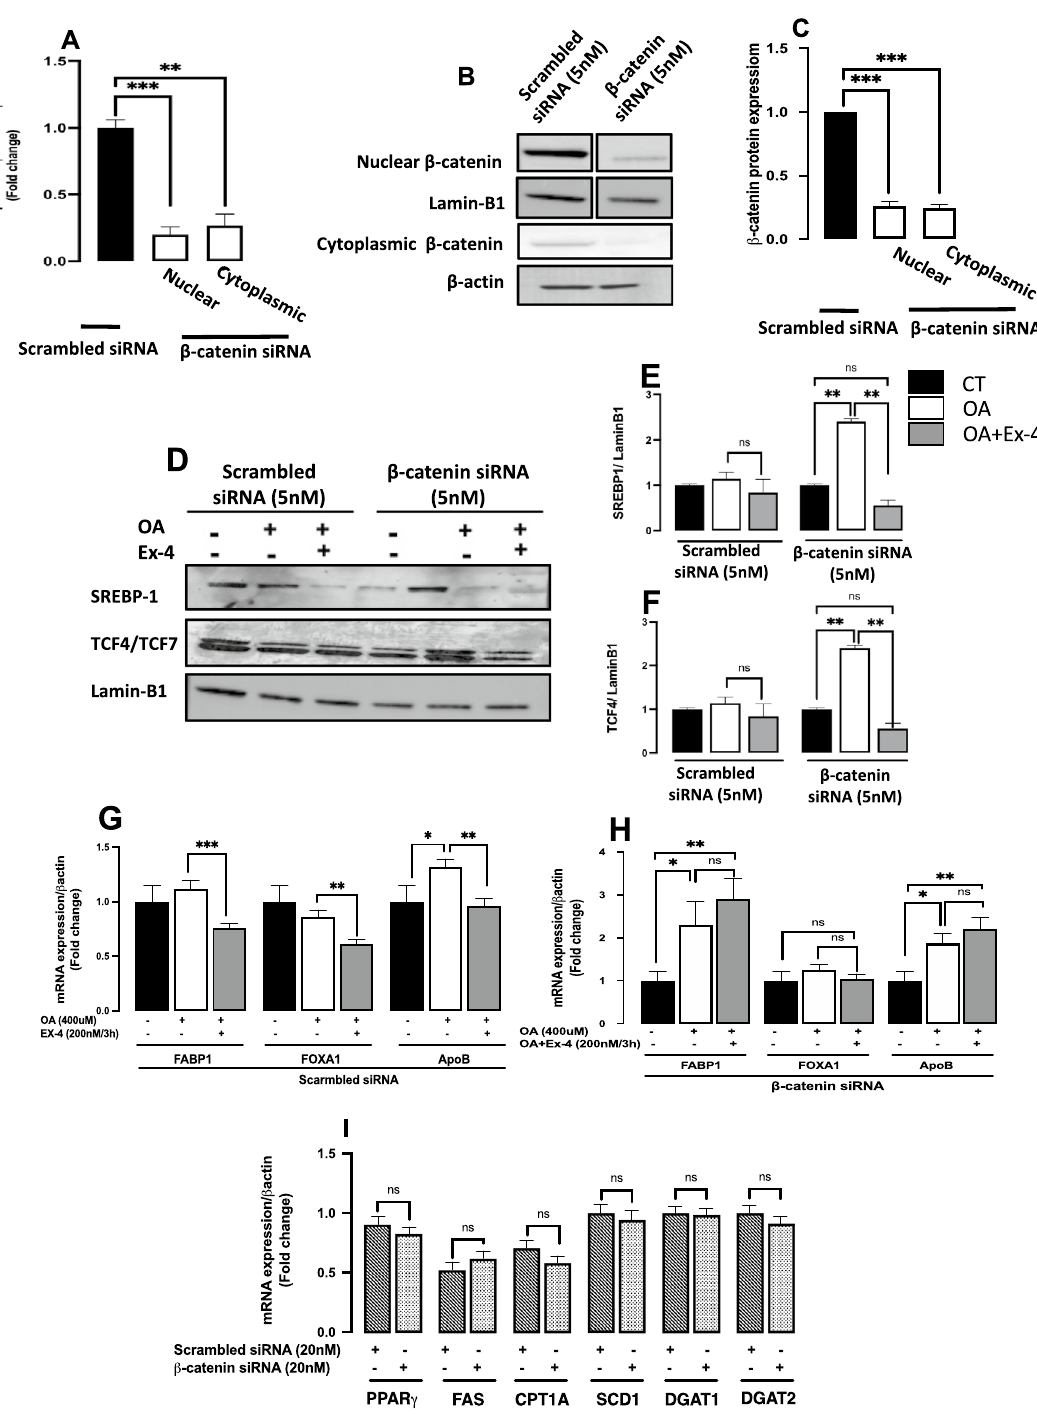
Figure 3. Ex-4 downregulates the expression of lipogenic transcription factors via the β-catenin pathway. Cytosolic and nuclear extracts were prepared from HepG2 cells transfected with 5 nM siRNA directed against β-catenin for 24 h and then treated with 400uM OA in the absence or presence of 200 nM Ex-4. ( A – C ) Silencing and quantification of β-catenin expression in cytoplasmic and nuclear fractions Full-length blots are displayed in Supplementary Fig.S.2 and S.3. ( D–F ) western blotting and quantification of the transcription factors SREBP-1 and TCF4. Nuclear proteins were normalized against Lamin-B1. All values are expressed as the mean ± SE (n = 6). * p < 0.05, ** p < 0.01, *** p < 0.001. Full-length blots are displayed in Supplementary